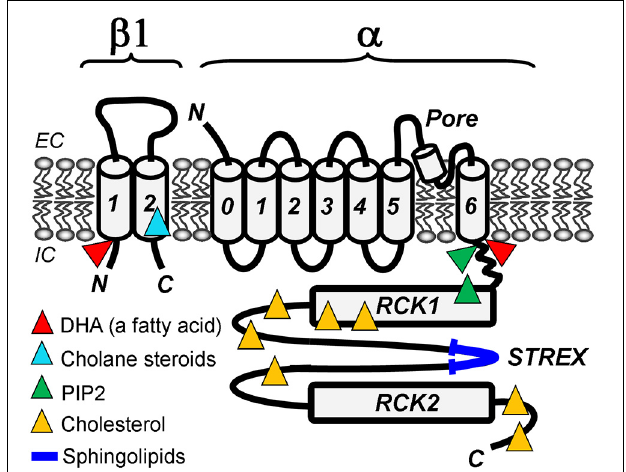
FIGURE 1 | Lipid-sensing areas in a BK heterodimer made of α (slo1) and β 1 subunits. The cartoon highlights protein regions in which mutations ablate lipid sensitivity of BK channels in cell-free systems, such as excised membrane patches or planar lipid bilayers. Whether these regions directly bind lipids or allosterically modulate BK channel function upon lipid binding to other BK areas remains